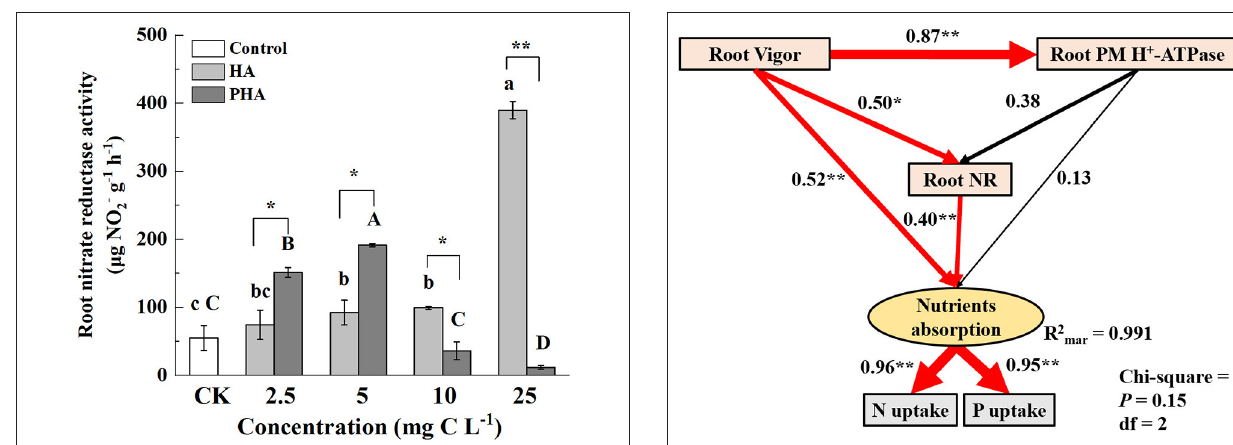
FIGURE 5 | Effects of 2.5–25mg C L − 1 of HA and PHA on root nitrate reductase activity. Different lowercase letters above the column indicate significant differences between HA and control treatments, while different capital letters above the column indicate significant differences between PHA and control treatments at P < 0.05, as determined by the LSD test. Significant differences between HA and PHA treatments at equivalent carbon concentrations were compared with two independent sample t -tests, * P < 0.05; ** P < 0.01.